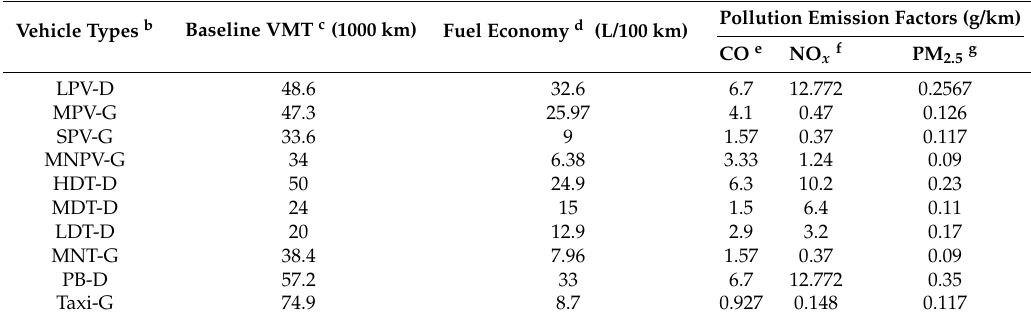
Table 3. The annual average vehicle mileage traveled (VMT), fuel economy and pollution emission factors a